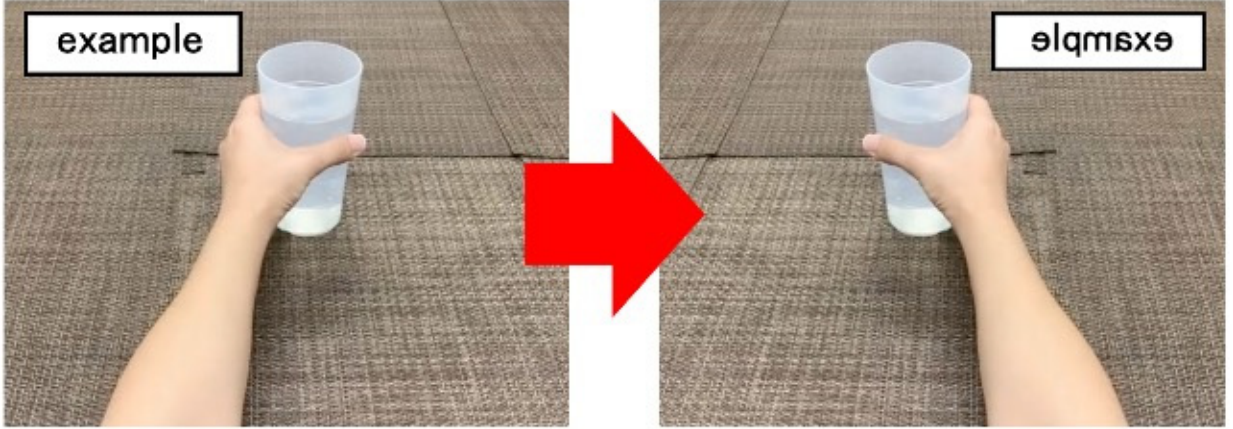
Figure 2. Inverted MI task images. We took images of the movements of a stroke patient’s nonpar- alyzed upper limb and inverted the images to make the paralyzed upper limb seem as if it were moving.